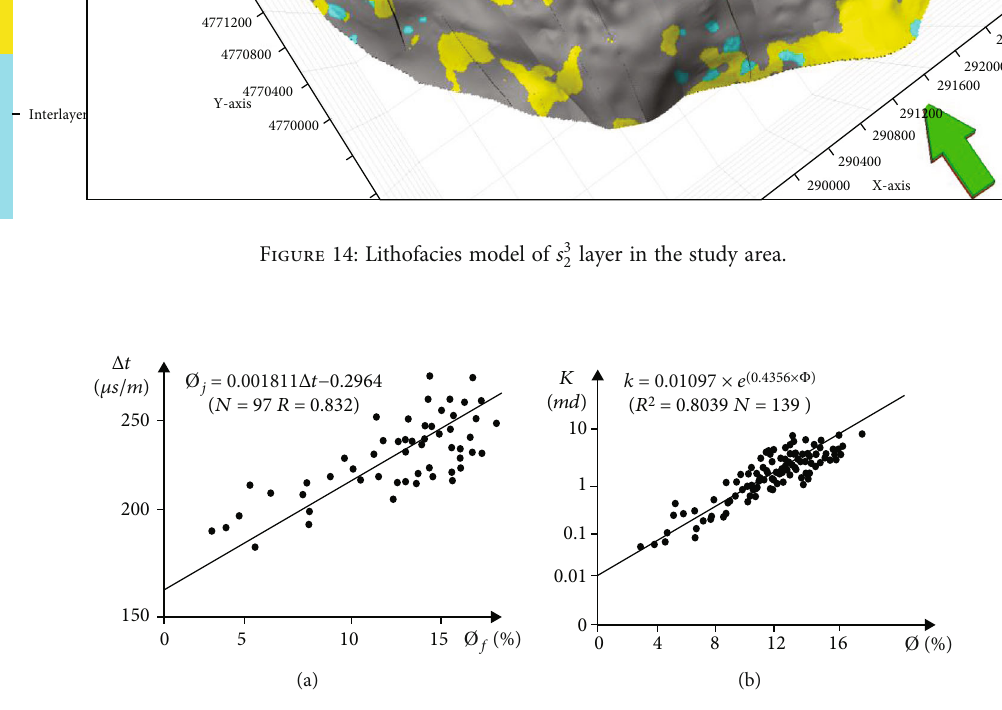
Figure 15: Relation of AC and porosity (a) and relation of permeability and porosity